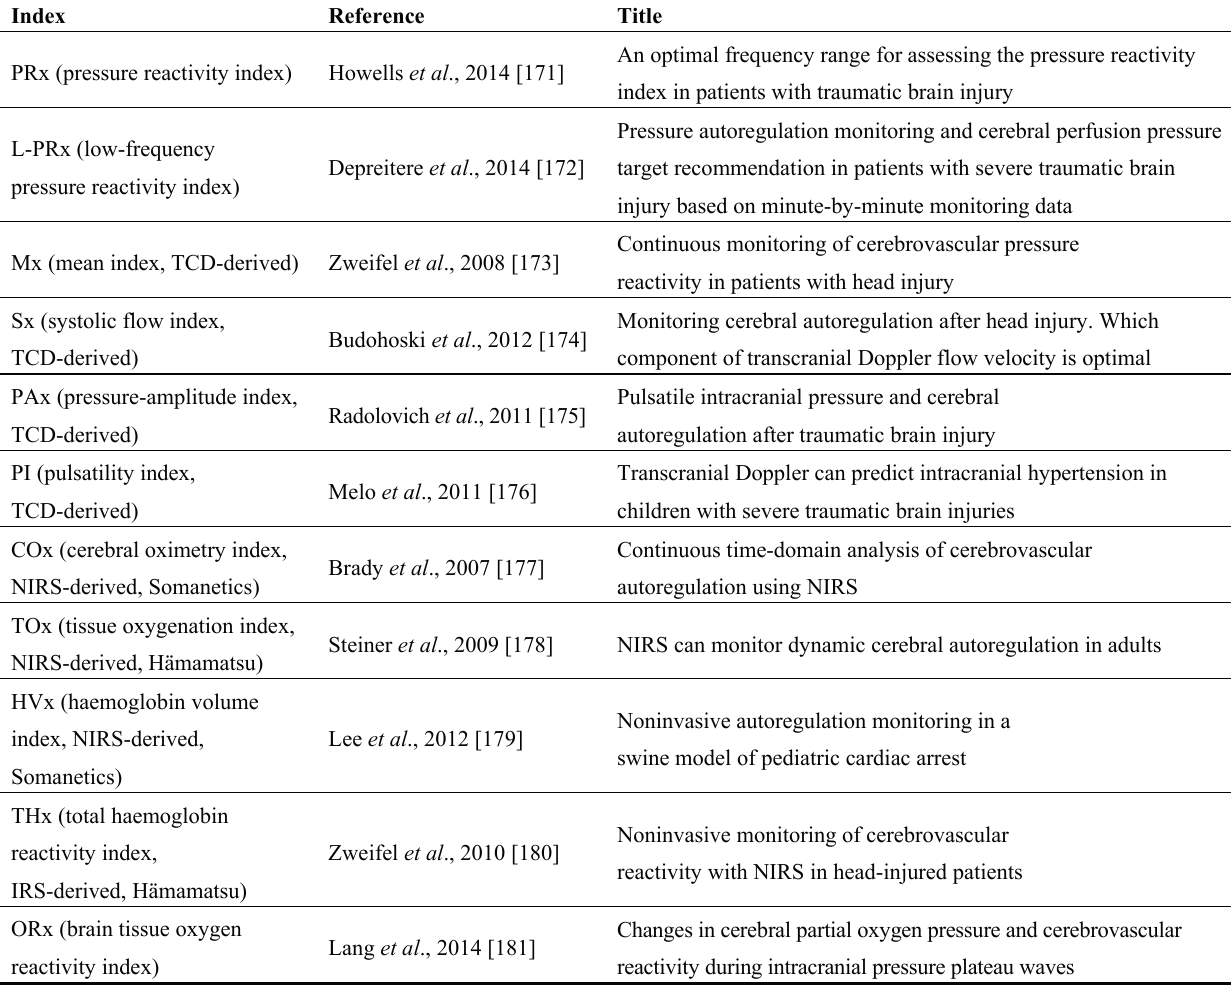
Table 4. Indices of cerebral